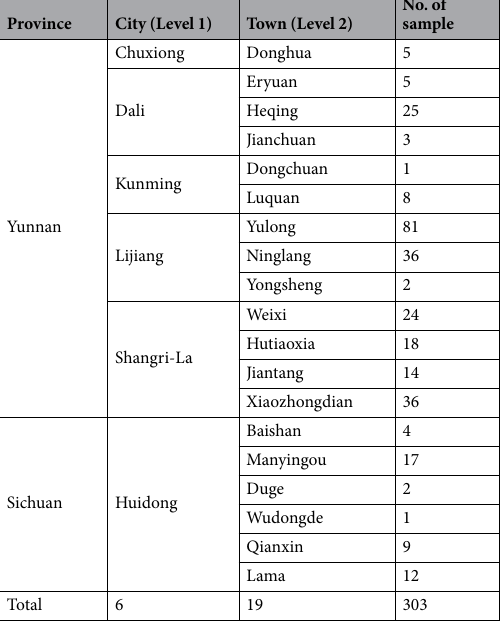
Table 1. The two-level BP neural network used to identify Maca